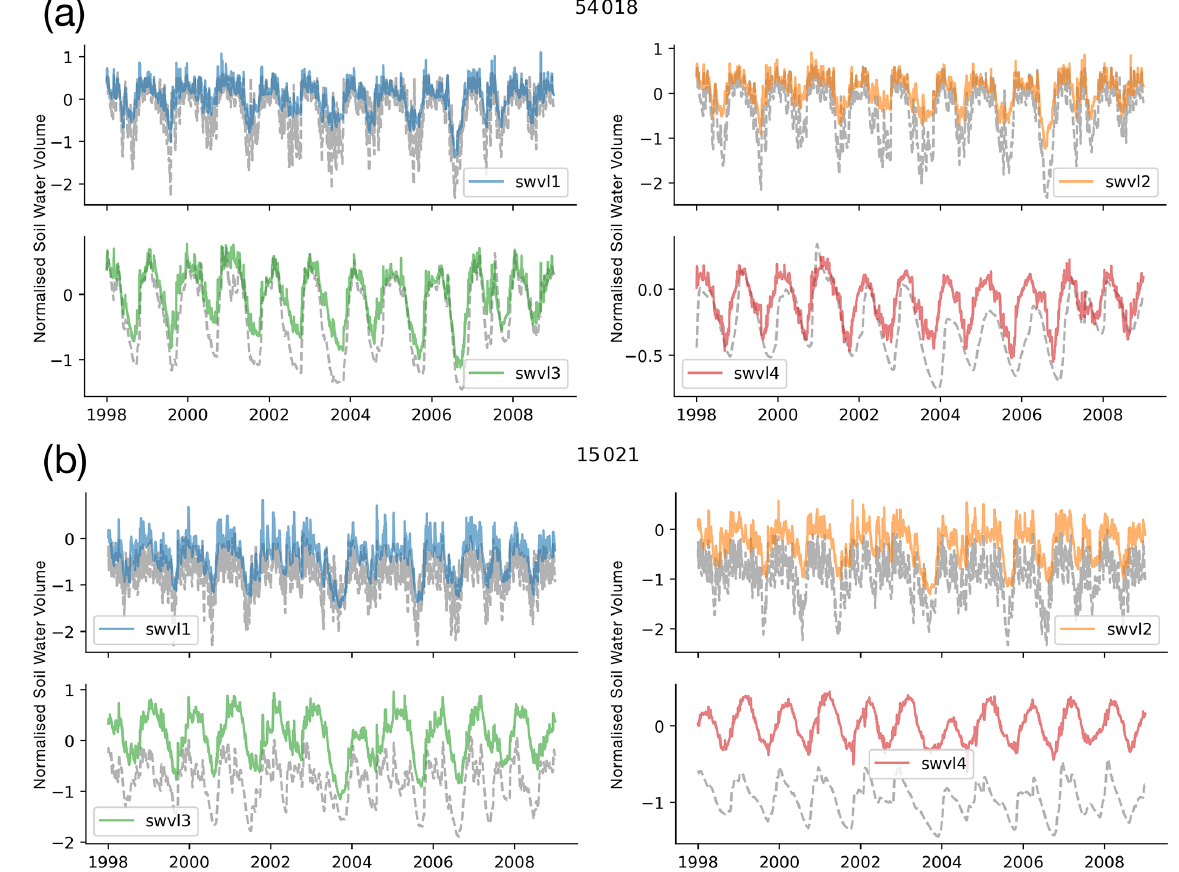
Figure 3. Time series of probe predictions (coloured lines) compared with the target variables (grey dotted lines). We show two catchments here, (a) 54018, Rea Brook at Hookagate, and (b) 15021, Burn at Burnham Overy (chosen to reflect both a catchment with a small bias and a catchment with a strong bias; see Appendix D for more information on these two catchments), and four soil moisture levels, swvl1 (blue), swvl2 (orange), swvl3 (green), and swvl4 (red). The probe captures the temporal dynamics of the soil moisture signals but shows systematic bias, consistently predicting variability about zero, which defines the mean GB-wide soil